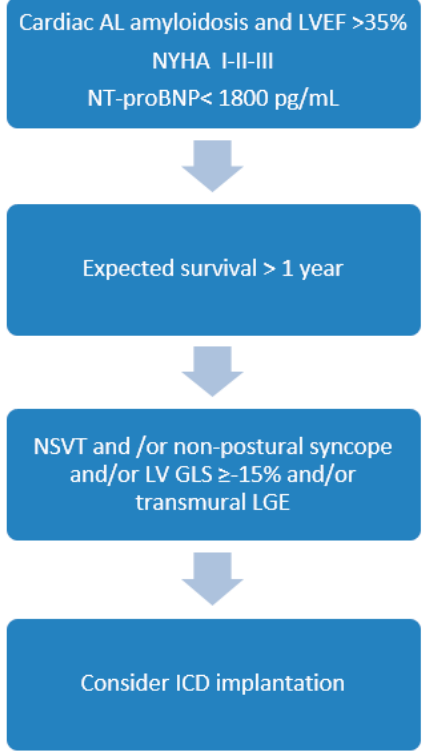
Figure 1. Proposed algorithm for qualifying patients with cardiac AL amyloidosis for ICD implantation in primary prevention. LVEF—left ventricular ejection fraction, T-proBNP—N-terminal pro B-type natriuretic peptide; NYHA—New York Heart Association; NSVT—non sustained ventricular tachycardia, LV-GLS—left ventricular global longitudinal strain assessed by speckle tracking echocardiography, LGE—late gadolinium enhancement in cardiac magnetic resonance imaging.